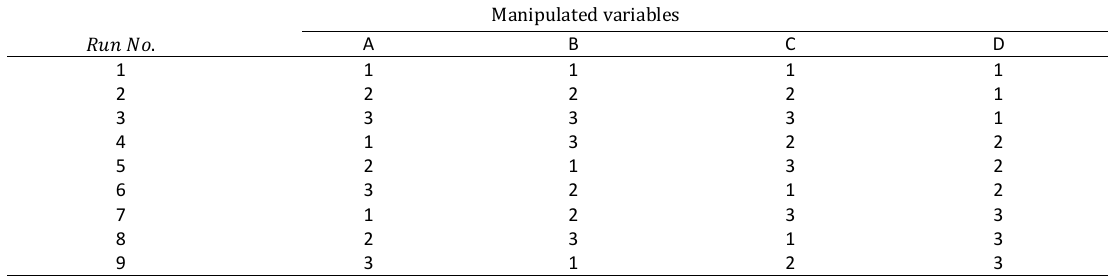
Table 2: Design of experiments for independent variables based on L 9 array (3 4 )